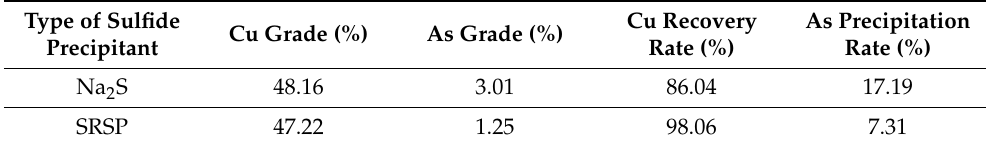
Table 1. The results of the contrastive experiment of copper selective recovery by SRSP and Na 2 S (experimental conditions: molar ratio of SRSP/Na 2 S to copper: 1:1, pH value: 0.70, reaction time: 40 min).